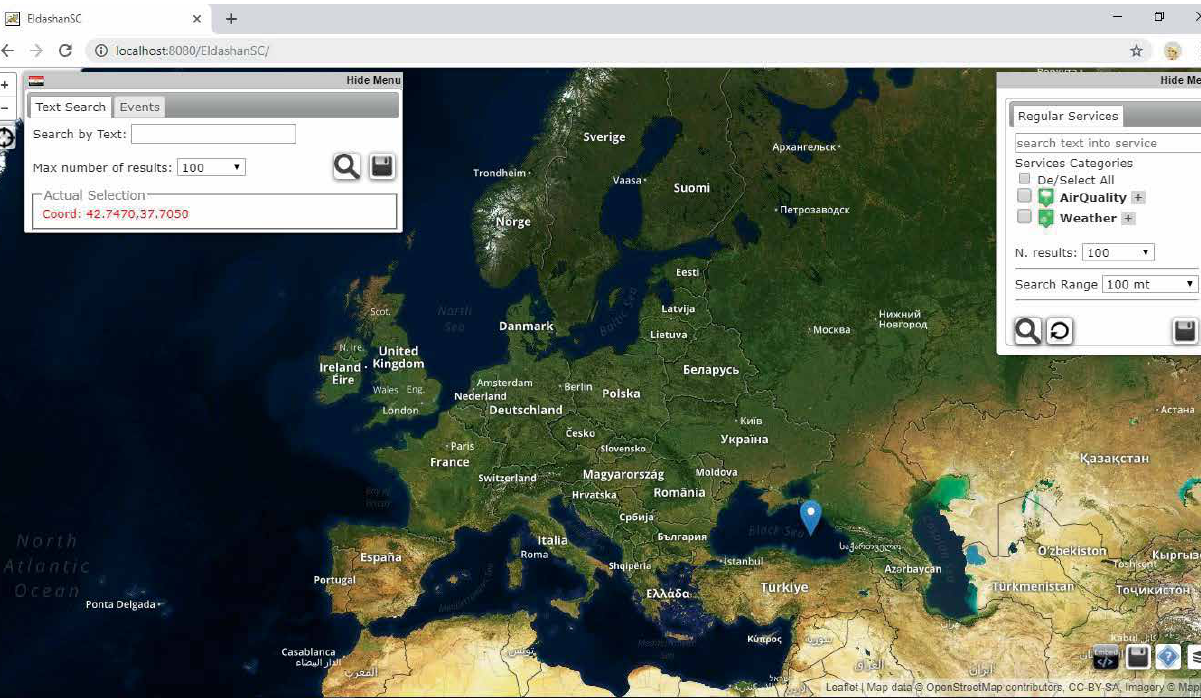
Figure 8: Dashboard for